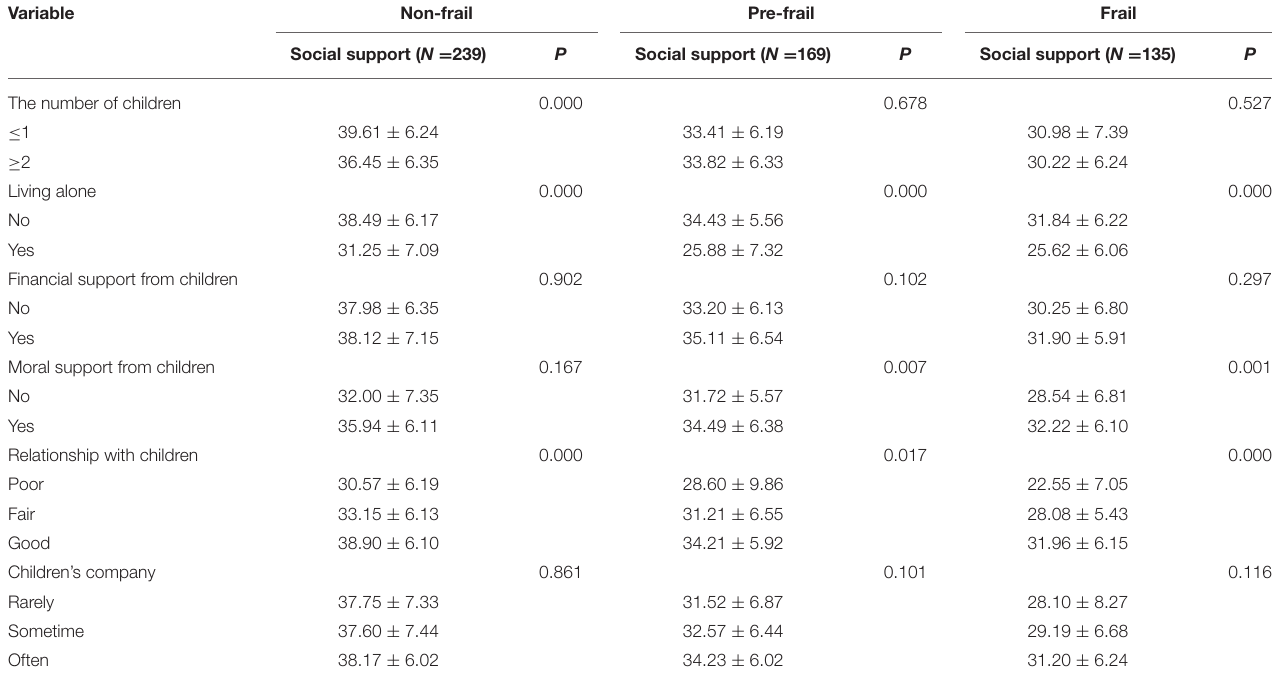
TABLE 4 | The impact of family environment on social support according to the frailty category.